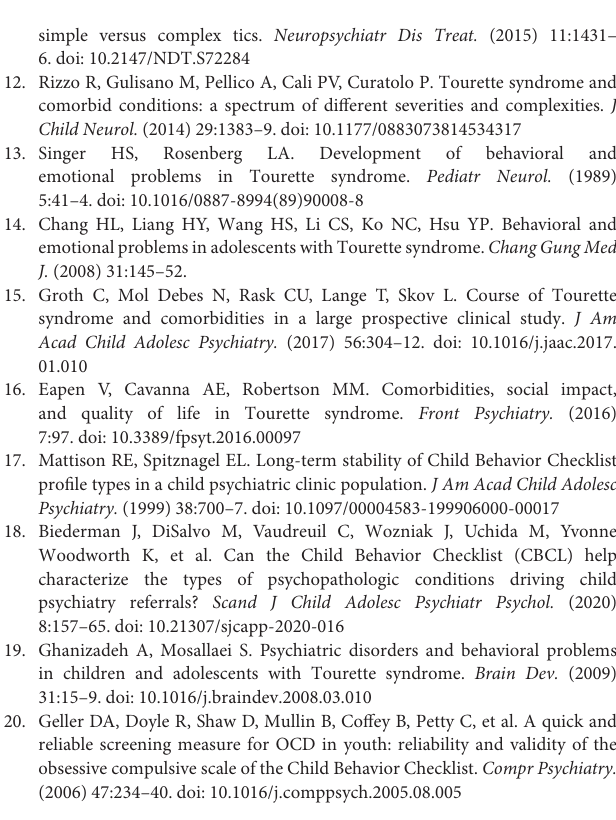
Supplementary Figure 1 | The CBCL profile of the Young Group and Old Group. Supplementary Table 1 | The subscales of